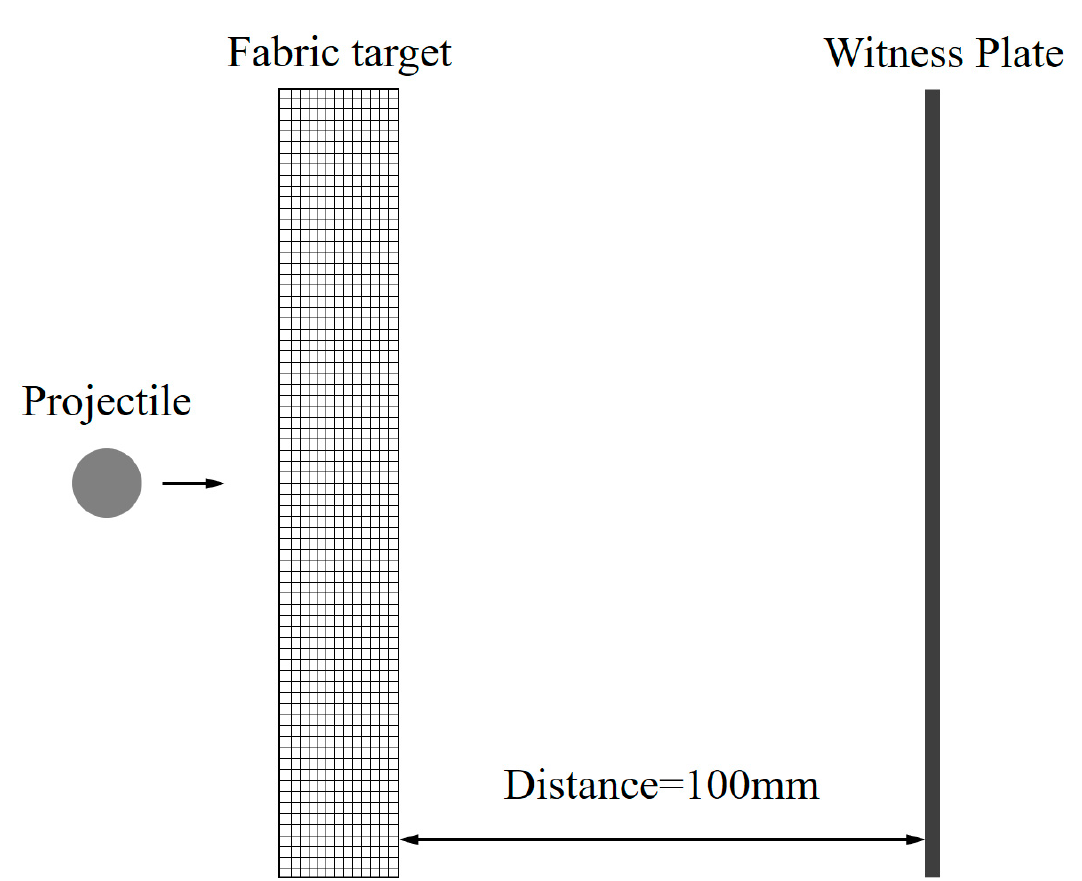
Figure 2. Configuration of the experimental setup.